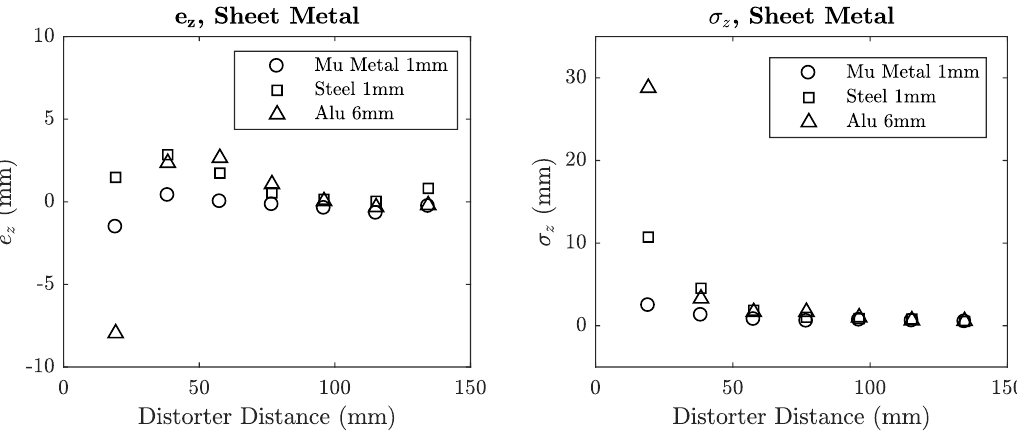
Figure A11. Position error plots for sheet metal distorters. Aluminium causes the most severe position error and highest standard deviation. A cross-over point is visible at approximately 100 mm in which the errors are minimised, before increasing for distances > 100